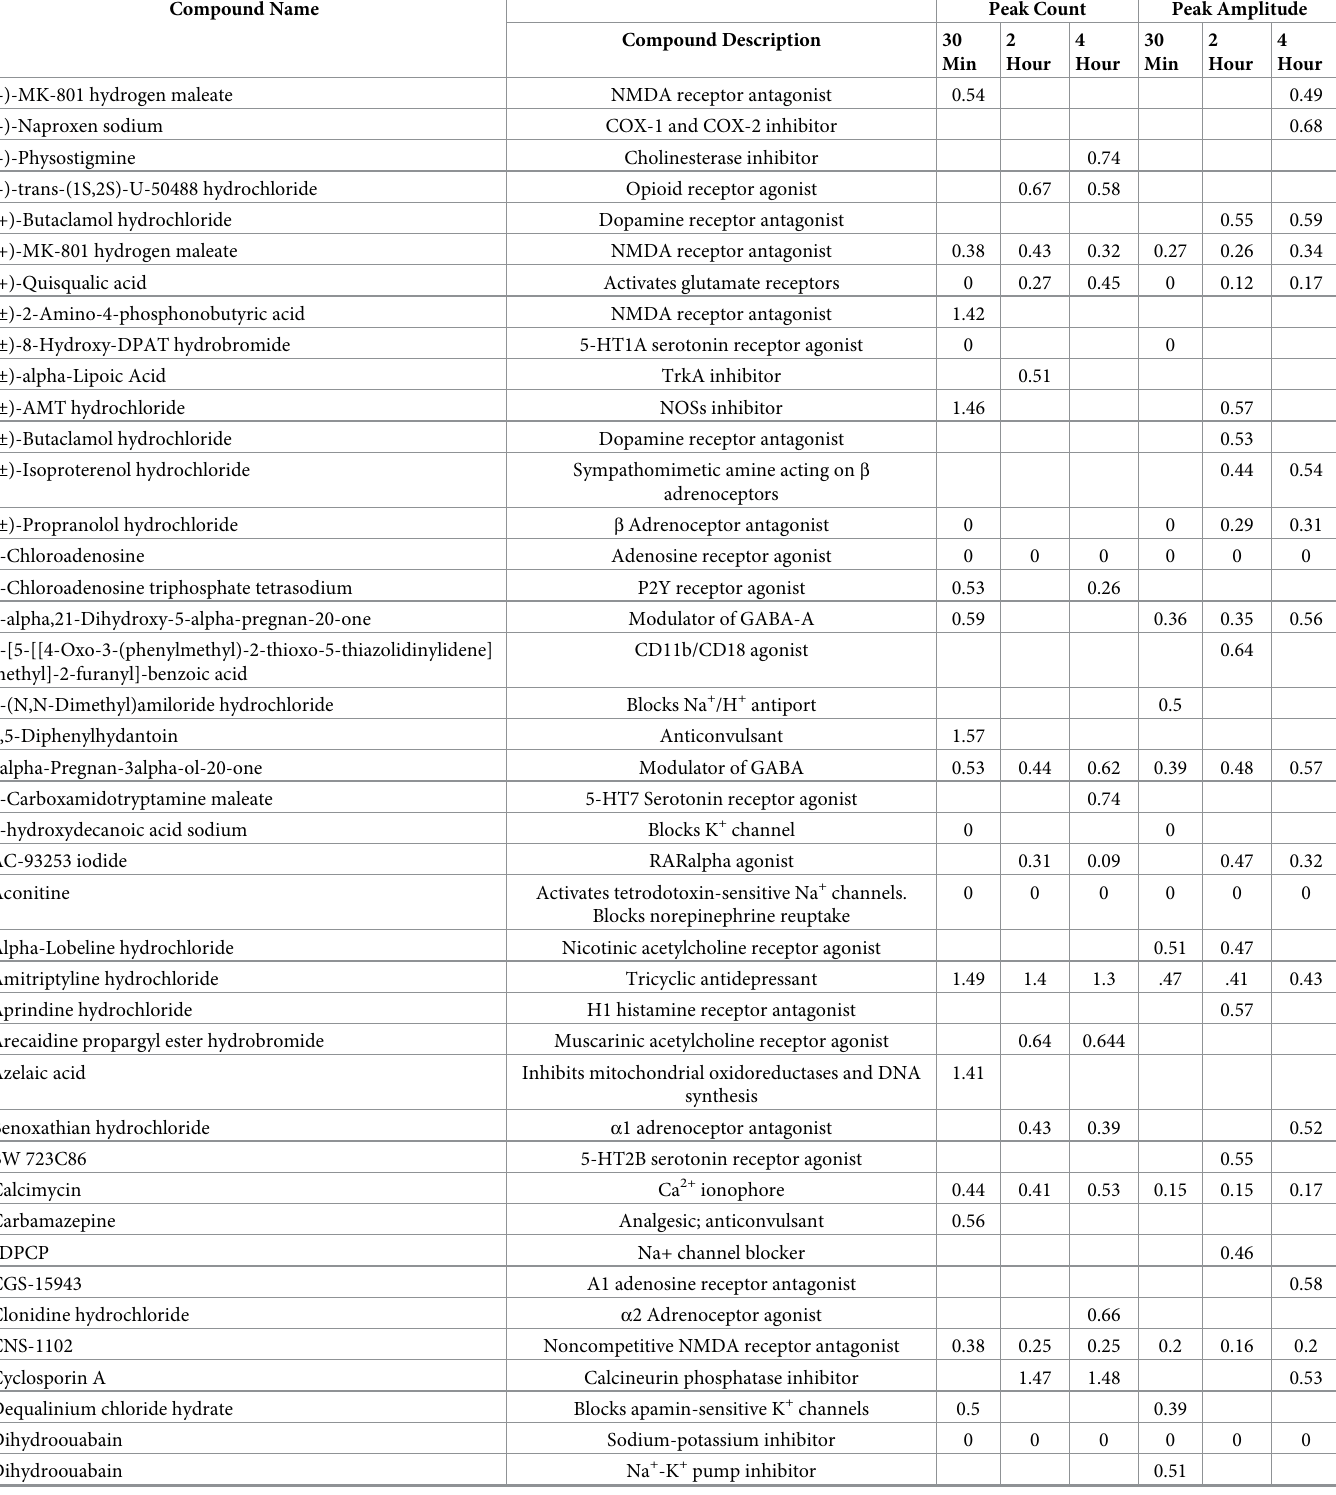
Table 2. Summary of all hits at 30 minutes, 2 hours, and 4 hours after compound addition for both peak frequency and